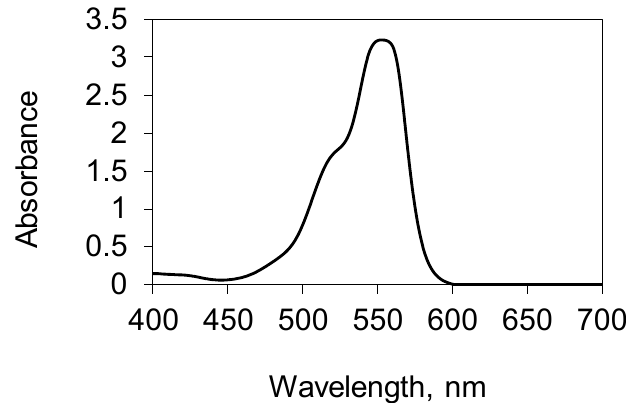
Figure 4. Absorption spectrum of rhodamine B standard (20 mg/L).